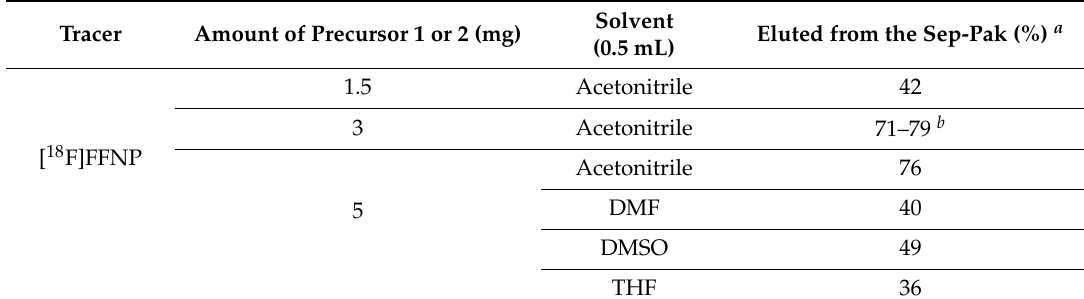
Scheme 1. Synthesis of [ 18 F]FFNP. Table 1. Elution conditions from the Sep-Pak to prepare [ 18 F]FFNP .